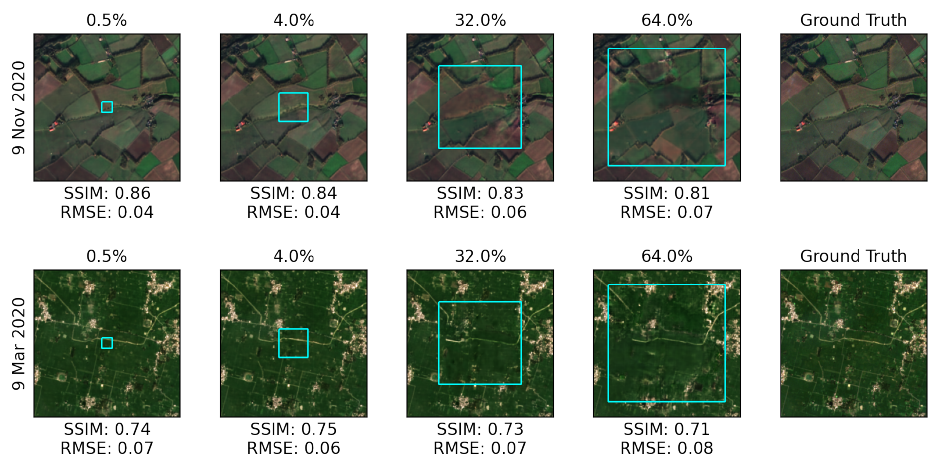
Figure 6. Samples of images reconstructed in the cloud coverage sweep procedure (ranging from 0.5% to 64.0% cloud cover) for MS-MT mode in Scotland ( top row ) and India ( bottom row ). The SSIM and RMSE metric values are shown for the inpainted region.